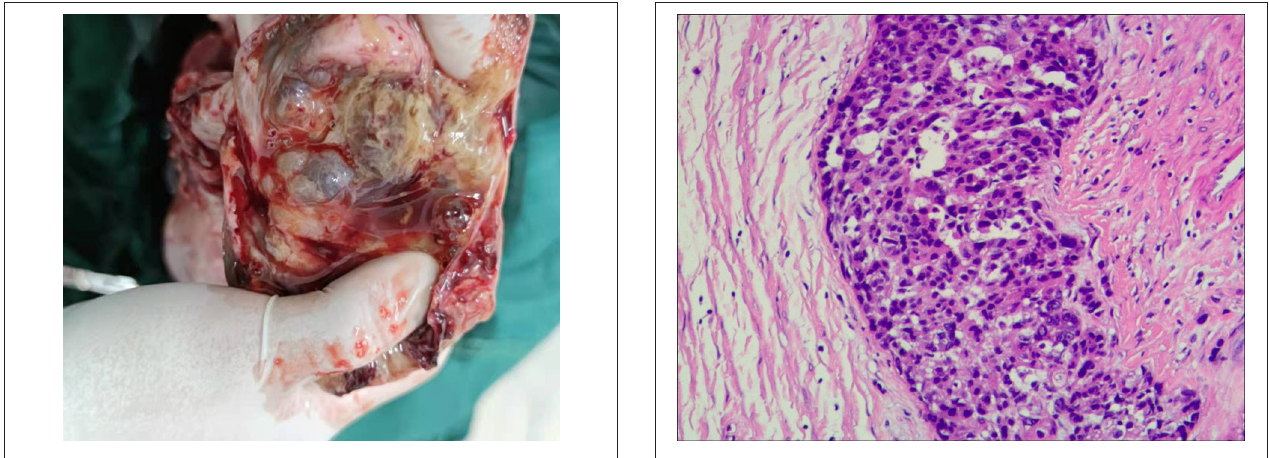
FIGURE 2 | Macroscopic appearance of tumor. FIGURE 3 | The histopathology results.